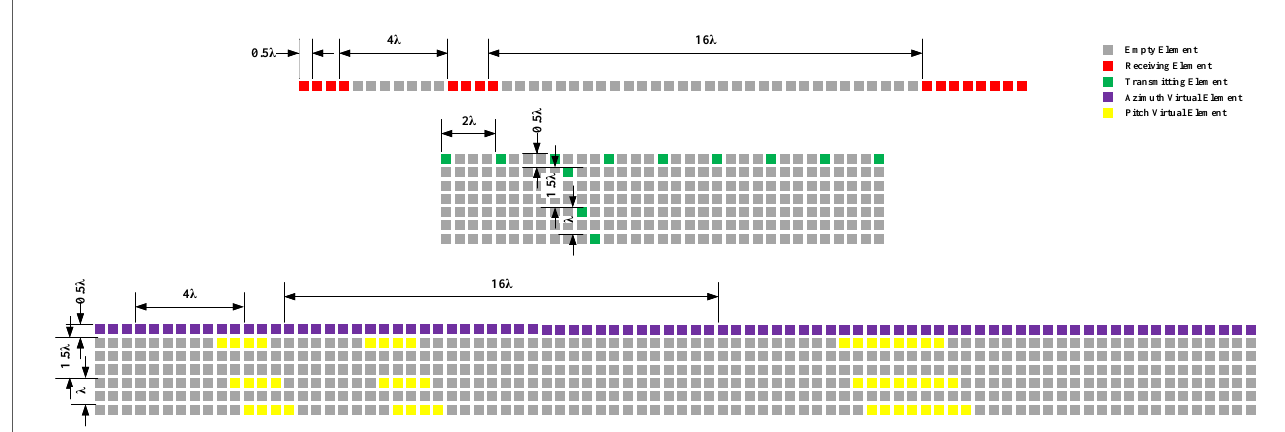
Figure 2. Virtual antenna array of TI Cascade FMCW MIMO